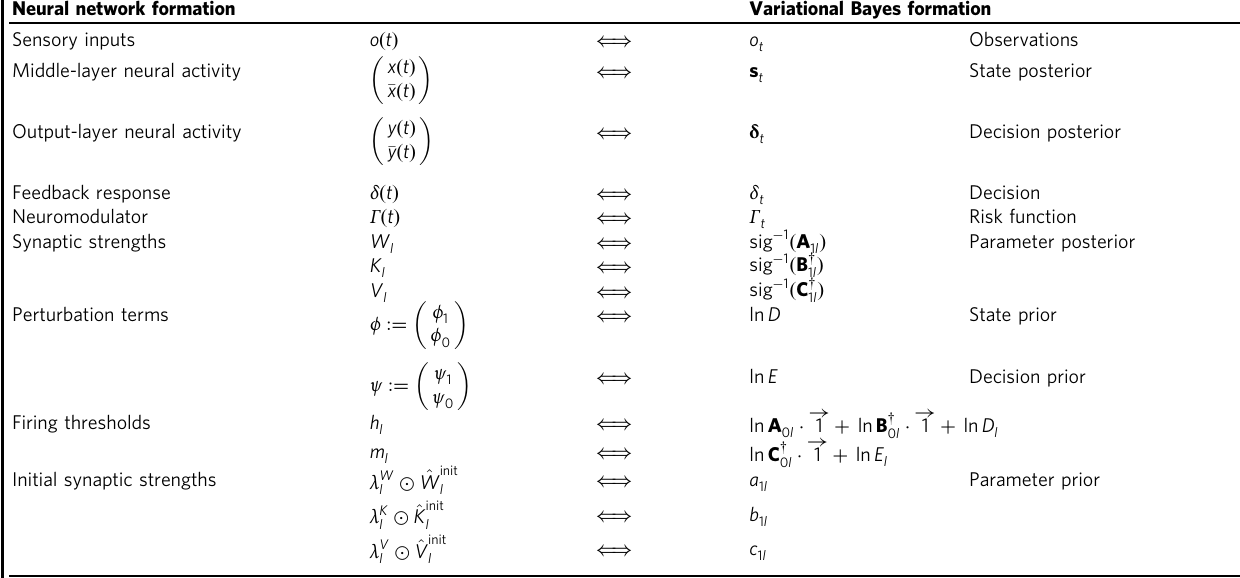
Table 2 Correspondence of variables and functions. Neural network formation Variational Bayes